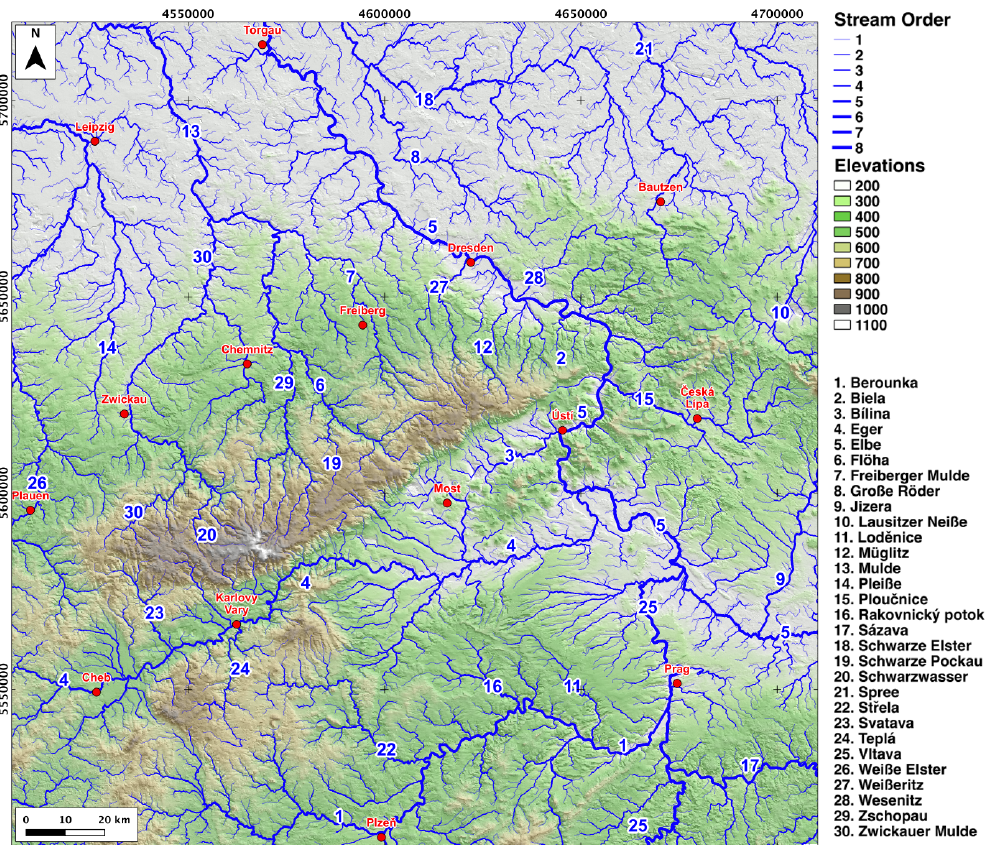
Figure 5. Drainage network of the Eger Rift and Ore Mountains regions extracted using TecDEM [8] and organized hierarchically using Strahler order